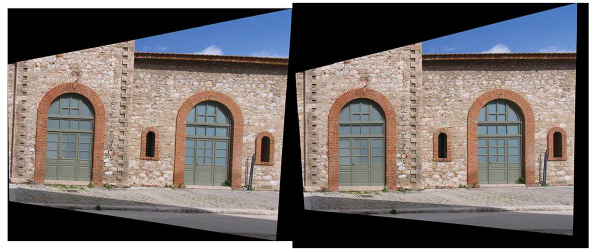
Figure 6. Rectified (cf. Fig.2) and rotated